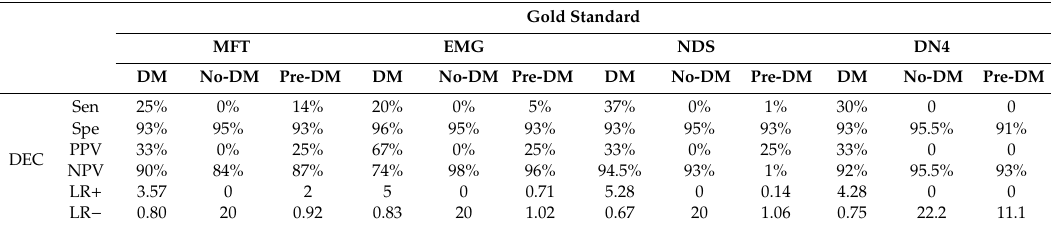
Table 2. Sensitivity (Sen), specificity (Spe), positive predictive value (PPV), negative predictive value (NPV) of dermal electrochemical conductance (DEC) compared to di ff erent tests as the gold standard. Gold Standard EMG MFT NDS DN4 Sen = 21.2% Sen = 15.3% Sen = 33.3% Sen = 21.4% Spe = 94.8% Spe = 93.5% Spe = 94% Spe = 93.4% PPV = 46.6% PPV = 26.6% PPV = 26.6% PPV = 20% DEC NPV = 81.3% NPV = 87.9% NPV = 95.6% NPV = 93.4% LR + = 4.13 LR + = 2.35 LR + = 5.55 LR + = 3.24 LR − = 0.83 LR − = 0.90 LR − = 0.71 LR − = 0.77